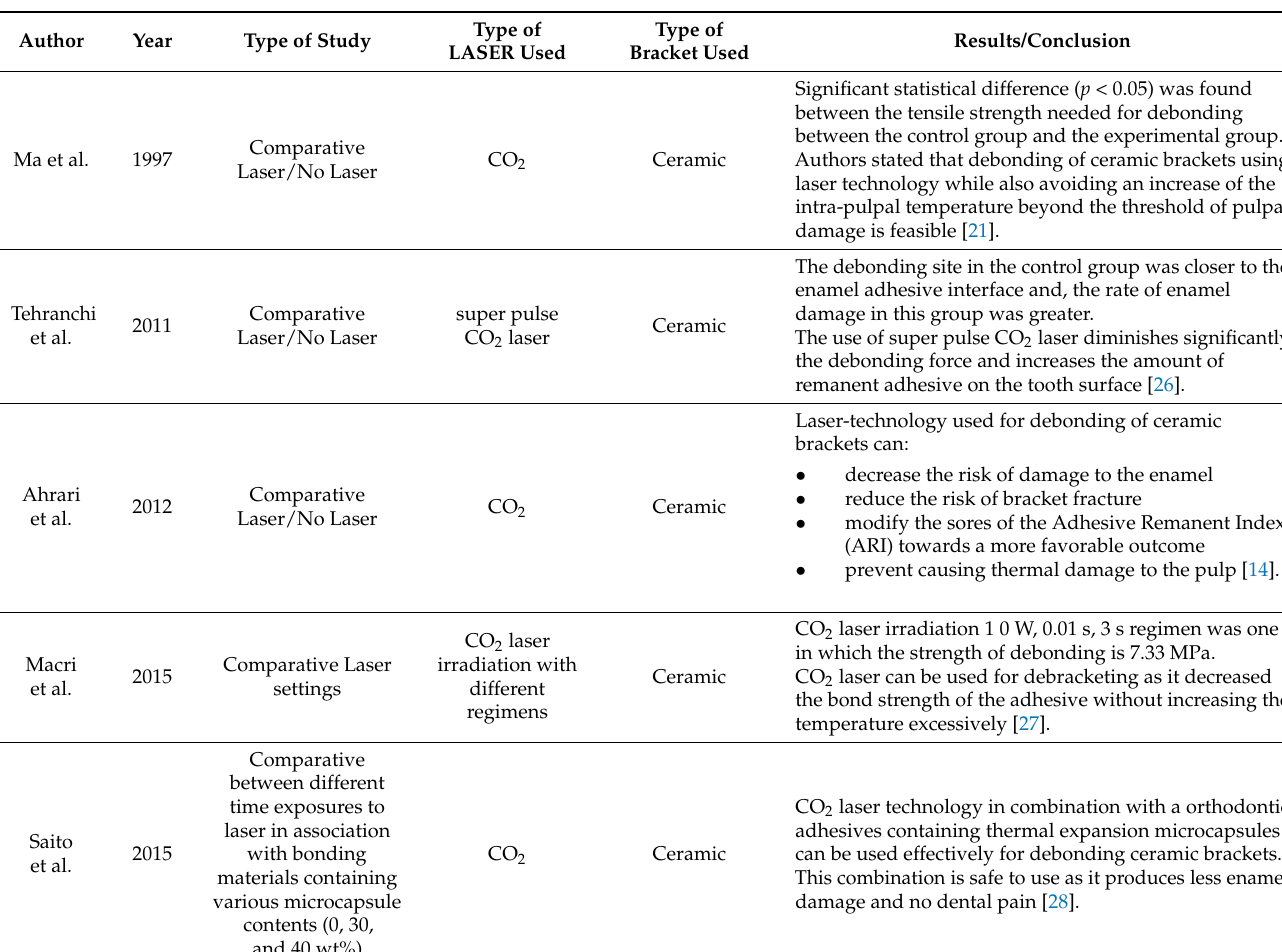
Table 1. Results of articles using CO 2 laser technology.